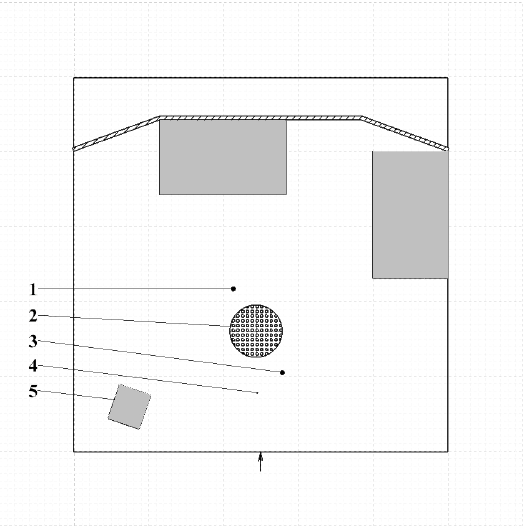
Figure 2. Top view of the test environment. The numbered obstacles with following characteristics: 1—vertical hexagonal wooden pole; 2—rubber ball; 3—vertical hexagonal wooden pole; 4—small vertical round rod; and 5—chair. The main grid size is 1 m. The location of the test device is marked with an arrow on the bottom side of the plot.